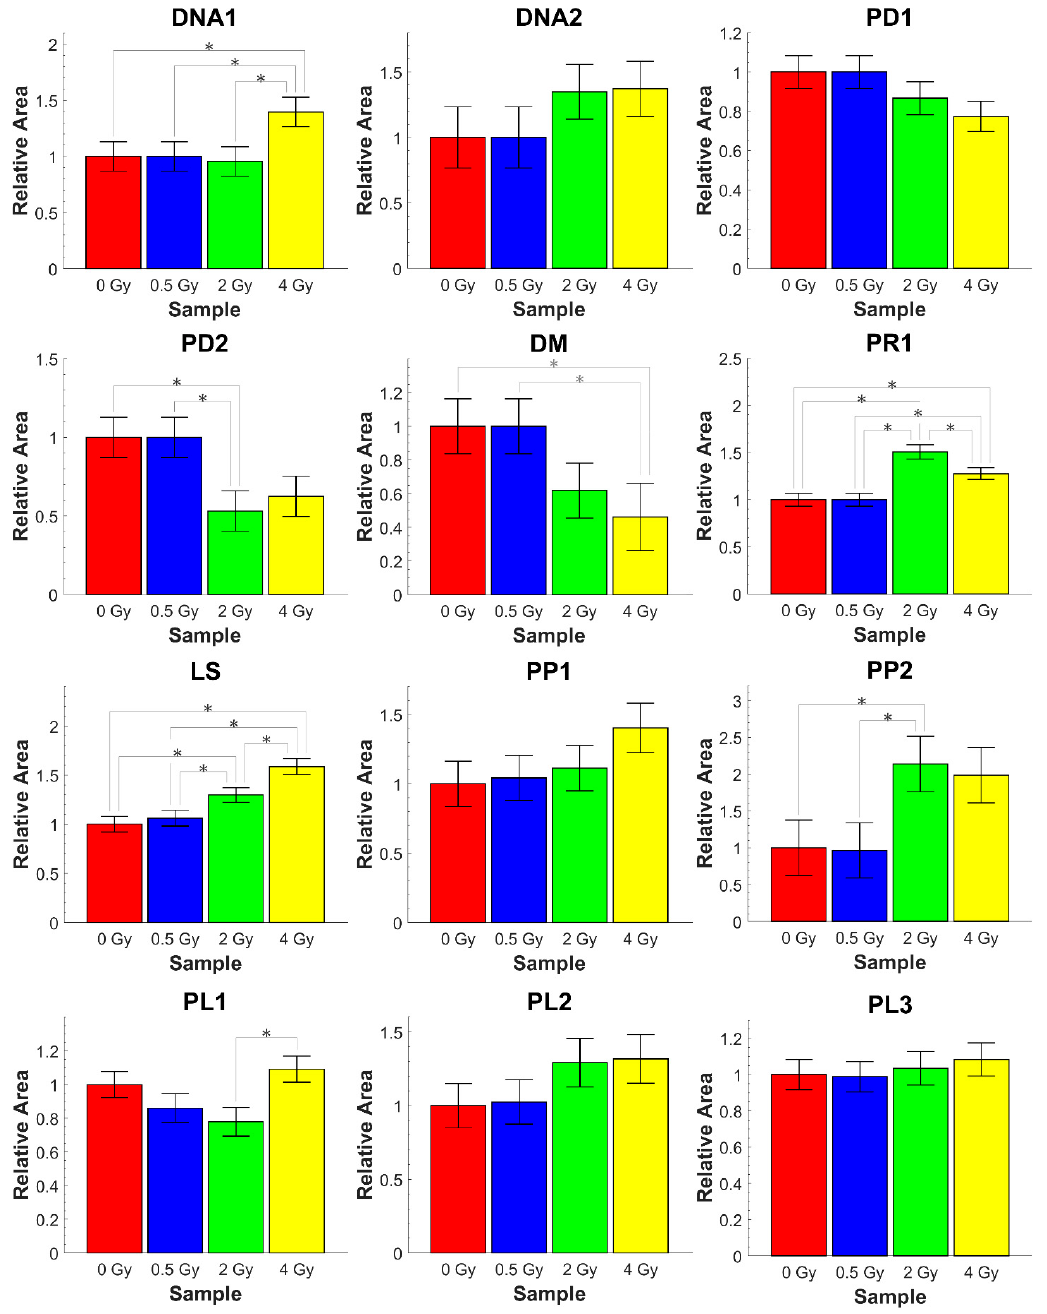
Figure 4. Comparison of the absorbance area ratios for different proton doses. See Table 1 for details on the reported ratios (Mean ± SD) that are normalized to the corresponding ratio value the non-irradiated sample. Asterisks indicate when a significant difference occurred at p < 0.05.